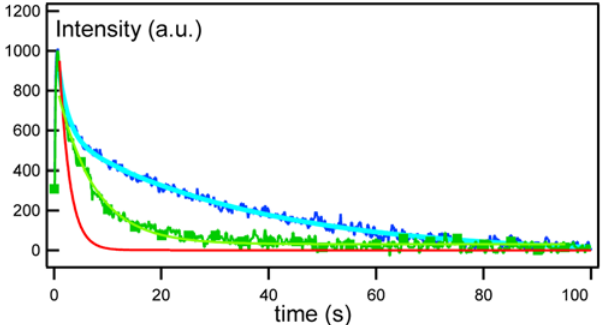
Figure 1. Example of recovery signals. The graph represents the fluorescence recovery signals obtained for differents molar ratios r = [B-L 12 ]/[S]: r =0 (red solid line), r =0.2 (green squares), r =1.9 (blue solid line). These signals are well-fitted by a single exponential law for r =0 (corresponding to D 0 =50 m m 2 s 2 1 ), a double exponential for r =0.2 (corresponding to D 0 =50 m m 2 s 2 1 and D 1 =3.2 m m 2 s 2 1 ), a triple exponential for r =1.9 (related to D 0 =50 m m 2 s 2 1 , D 1 =3.2 m m 2 s 2 1 and D 2 =1.6 m m 2 s 2 1 .